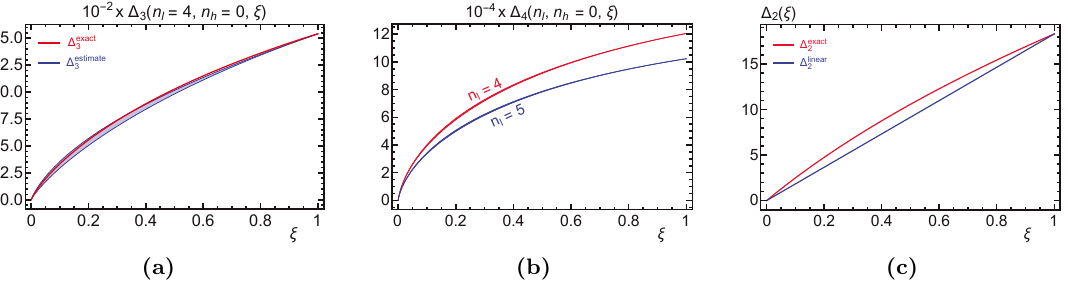
Figure 3. (a) Estimate of the three-loop massive lighter quark e(cid:11)ects on the relation between the MS and pole masses for n ‘ = 4 (blue band) versus the exact result (red line). (b) Estimate of the four-loop term (cid:1) 4 for n ‘ = 4 (upper red band) and n ‘ = 5 (lower blue band). The uncertainty bands are estimated from the di(cid:11)erence of two consecutive orders of the approximation. (c) Lighter massive quark correction to the O ( (cid:11) 2 ) term of the MS-pole relation. In red the exact form of s eq. (3.17) is shown, while blue shows the linear approximation of eq.